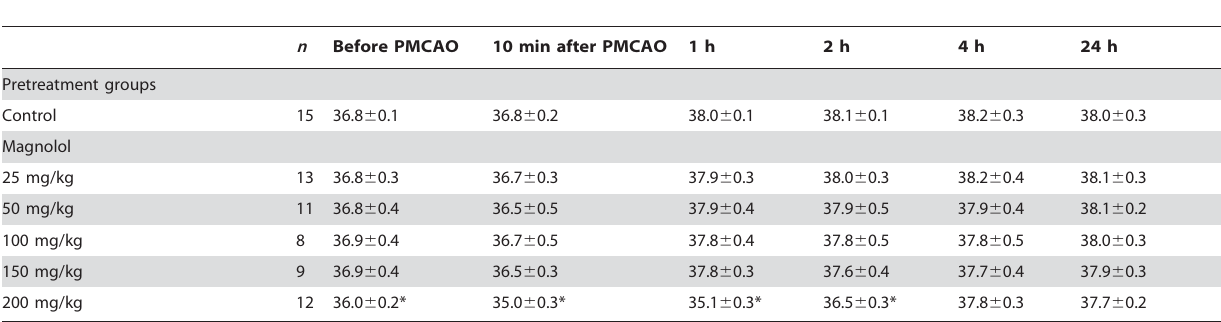
Table 2. The changes of core temperatures obtained after vehicle or magnolol treatment in rats subjected to permanent middle cerebral artery occlusion (PMCAO) in the